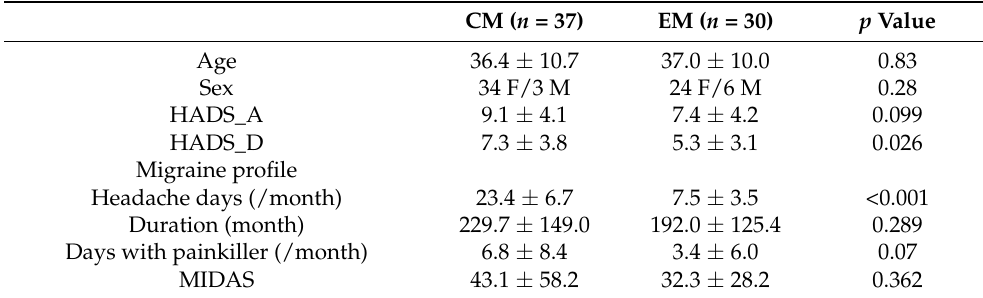
Table 1. Demographics, psychological characteristics and headache profile in chronic and episodic